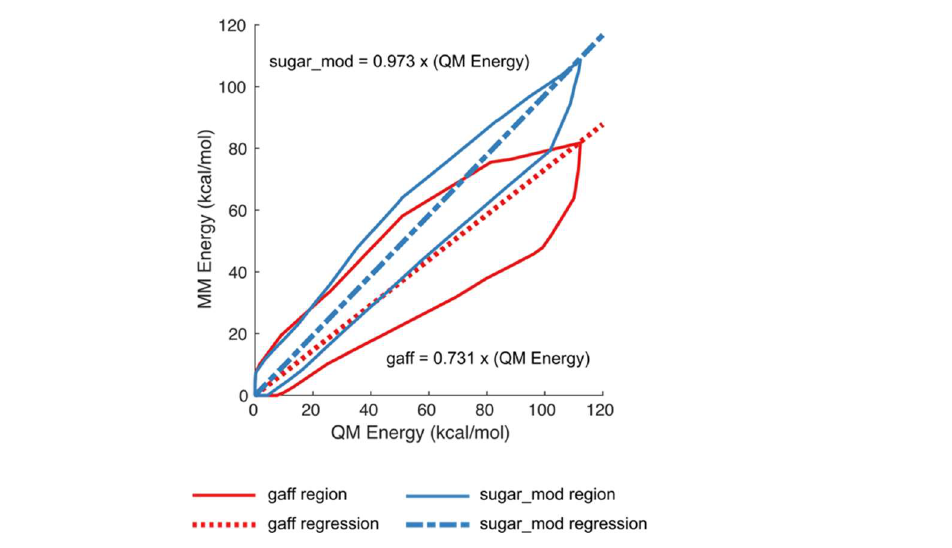
Figure 3. Comparison of molecular mechanics (MM) energies calculated using the gaff and sugar_mod force field parameters vs. quantum mechanics (QM) energies. The total sample size used was n = 47,596 structures. For clarity purposes, only the boundary of all data points is shown rather than individual data points. The red, solid and dashed, lines represent the energies calculated using the gaff force field parameters. The blue, solid and dashed, lines represent the energies calculated using the sugar_mod force field parameters.